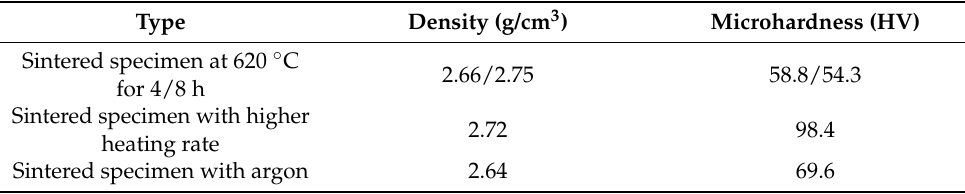
Figure 16. SEM images showing the sintered Al7075 specimens under different sintering atmospheres to 580 ◦ C for 20 min with applied ( a ) argon and ( b ) vacuum. Table 6. Density and microhardness of Al7075 with optimized sintering